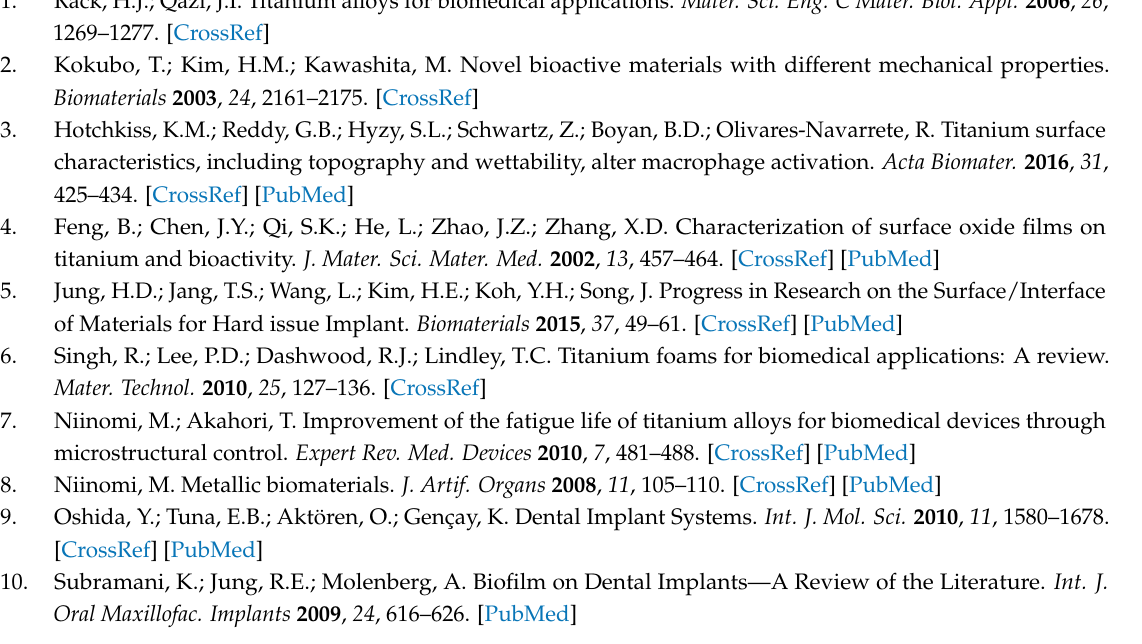
Figure S1: Surface morphology of pure Ti (a), Ti-MAO-N0.5(b) and Ti-MAO-N10 (c) after soaking in biomimetic mineralization solution for 24 days, Figure S2: The surface morphology of MAO specimens with different N implantation dose after cell cultured for 2 days: Ti-MAO-N0.5 (a,b), Ti-MAO-N10 (c,d), Figure S3: The alkaline phosphatase activity of osteoblasts on pure Ti and Ti-MAO-N1.0